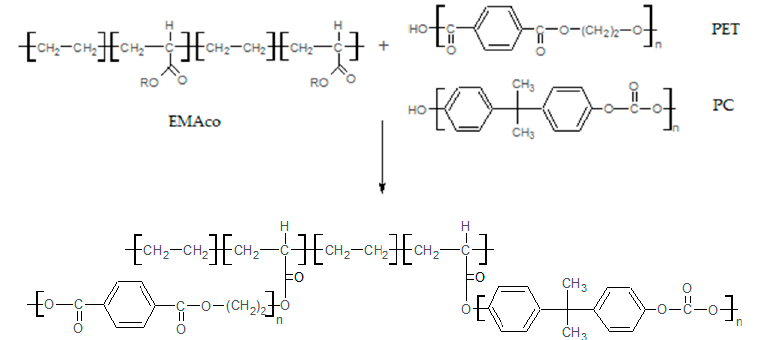
Figure 5. Possible reactions involved during the extrusion of the POST-I blend with EMAco.